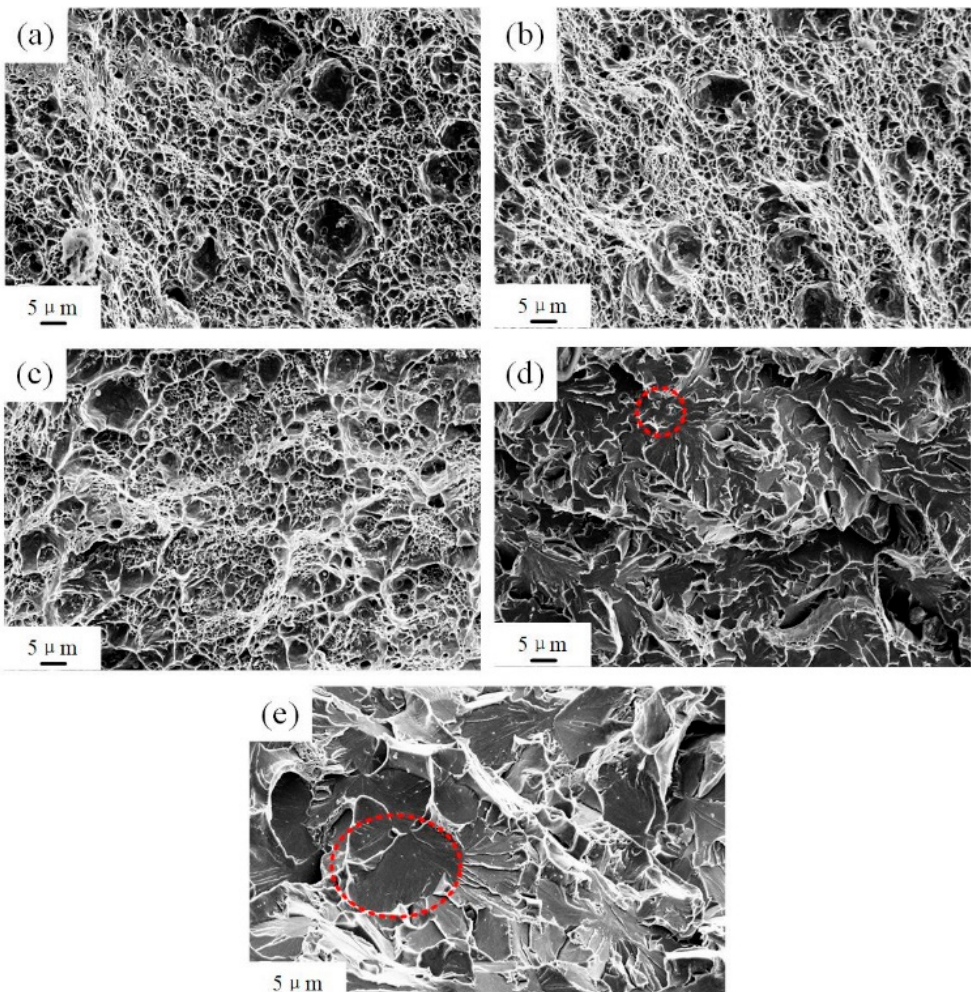
Figure 4. Fracture surface morphologies of SA738 Gr.B steel tempered at 630 °C ( a ), 650 °C ( b ), 670 °C ( c ),690 °C ( d ), 710 °C ( e ) after a Charpy impact test at − 45 °C .